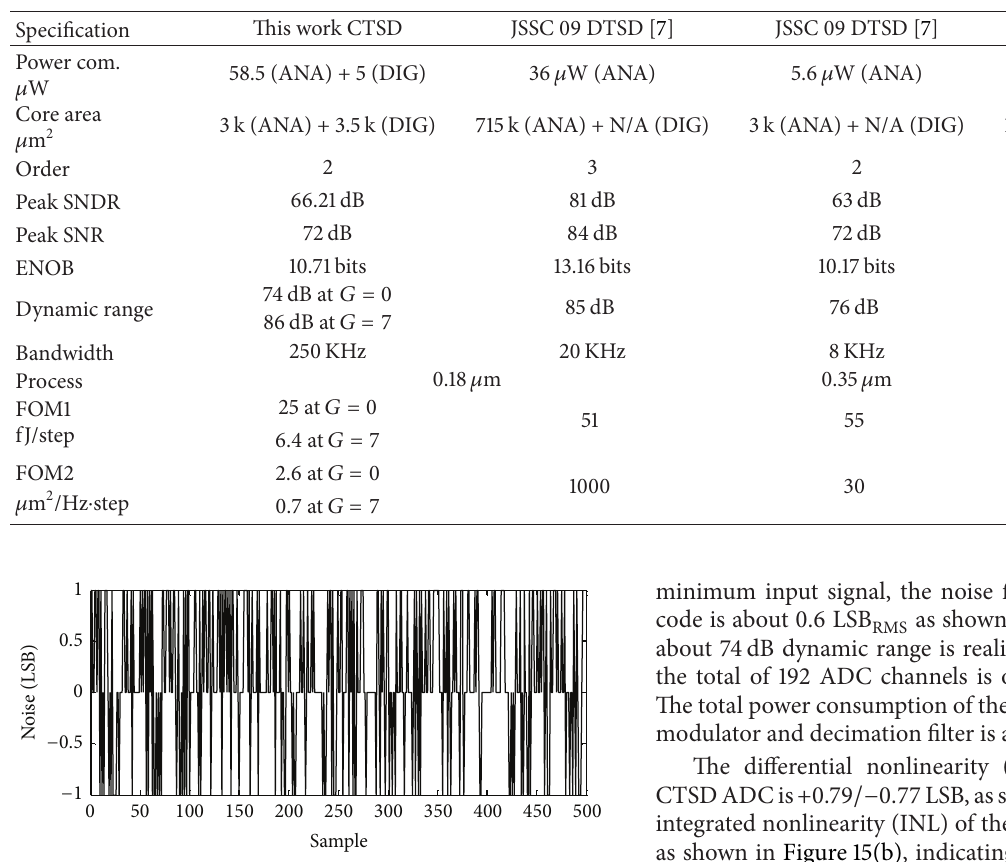
Table 1: CIS-purpose ΣΔ ADC figure-of-merit comparison.